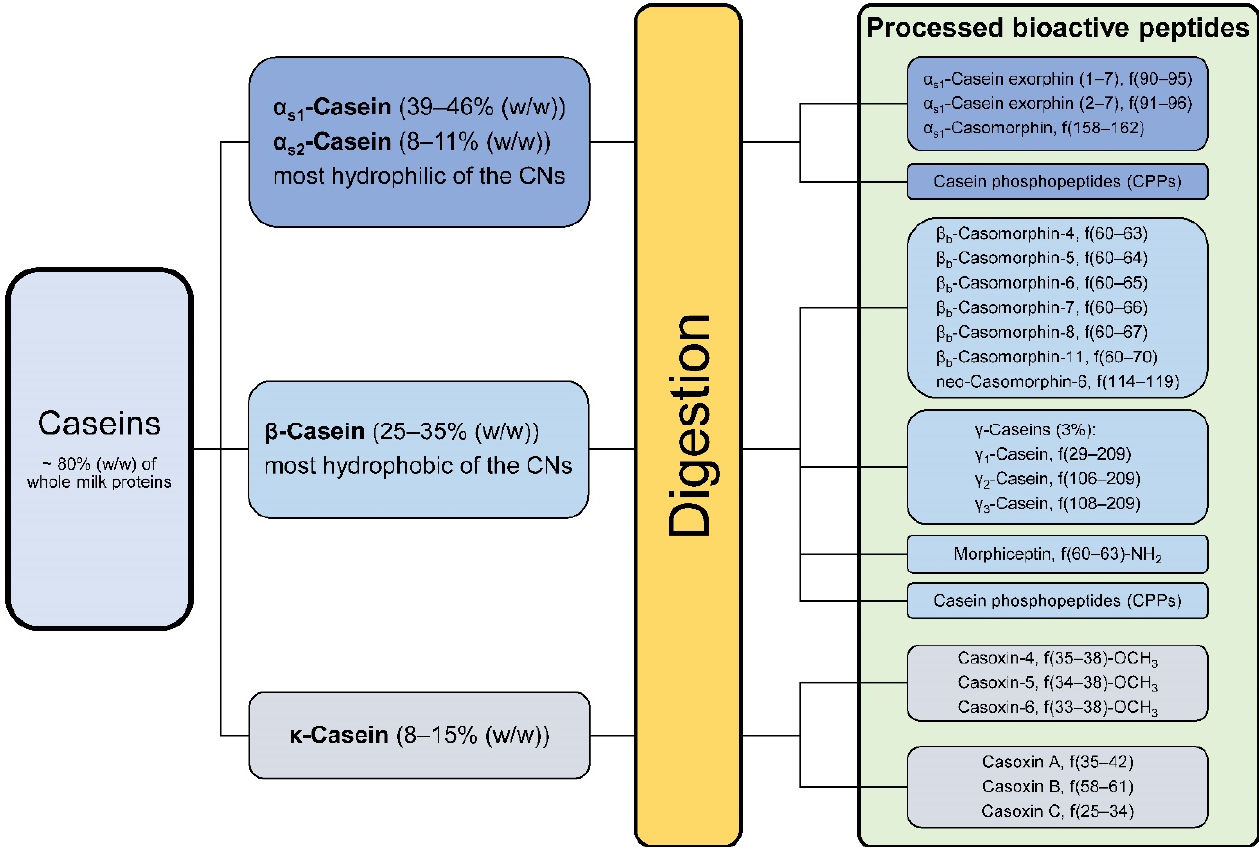
Figure 2. Overview of the insoluble casein proteins and their share in the total casein fraction. The green box indicates some important processed peptide variants after casein digestion. Some of them are α -amides, methyl esters or have free α -carboxyl groups [20–22].